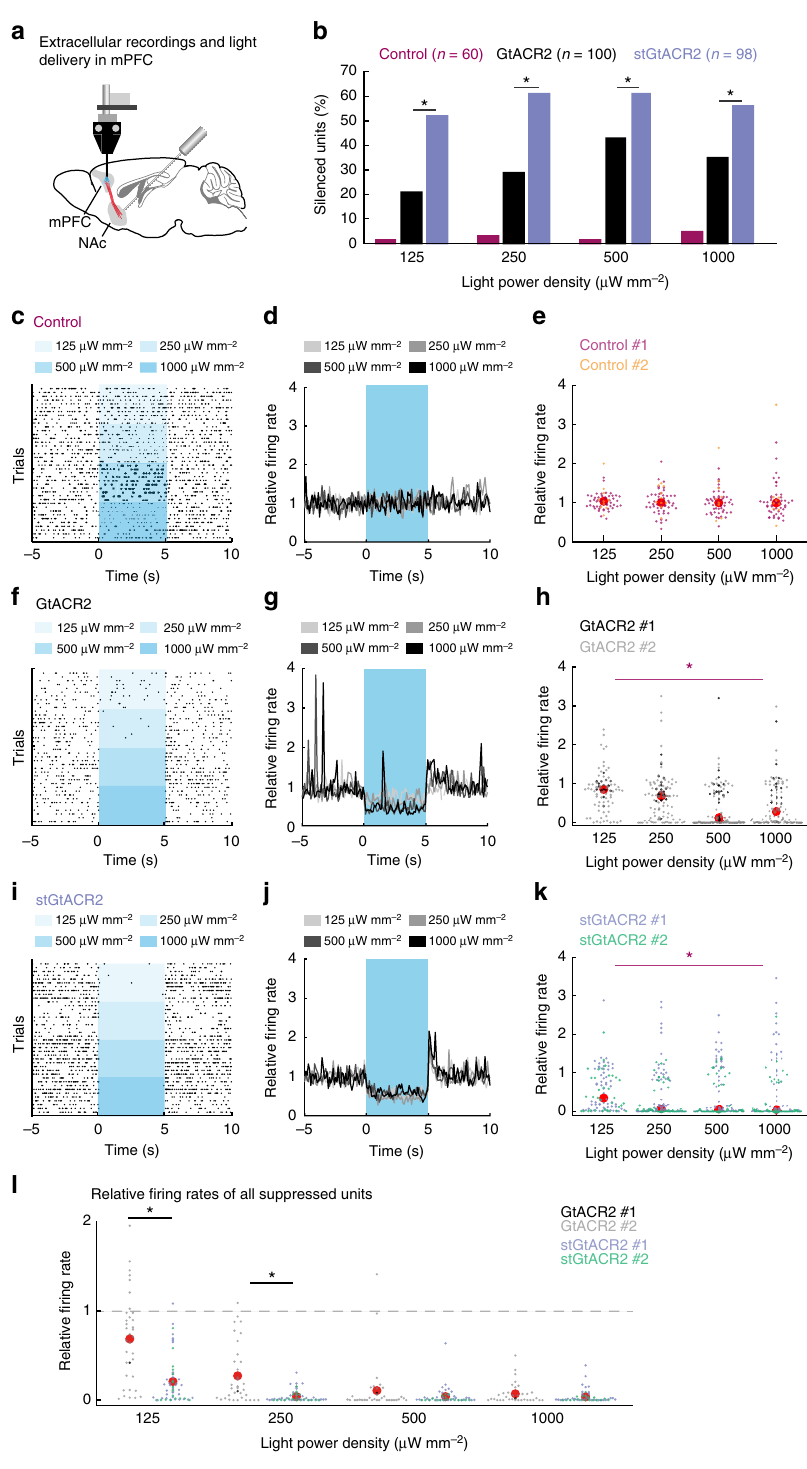
(Fig. 7d). These fi ndings further indicate that stGtACR1 and stGtACR2 allow sustained inhibition of neuronal activity with high light sensitivity. BLA inhibition using stGtACR2 impairs fear extinction . To verify that stGtACR-mediated inhibition can indeed be used to silence neurons in behavioral experiments, we applied stGtACR2 to suppress basolateral amygdala (BLA) activity during extinction of auditory-cued fear conditioning 42 . The BLA plays a central